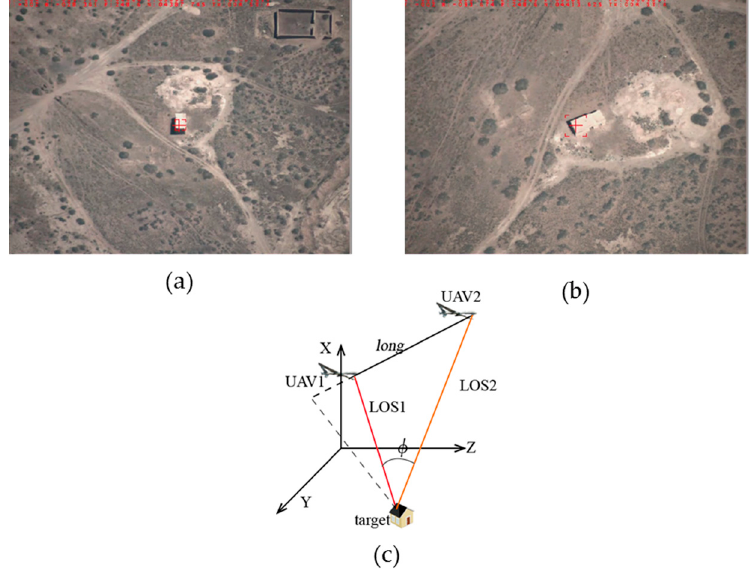
Figure 16. Feature position 4: ( a ) target detection by UAV1; ( b ) target detection by UAV2: and ( c ) positional relationship graph between the two UAVs and the target.